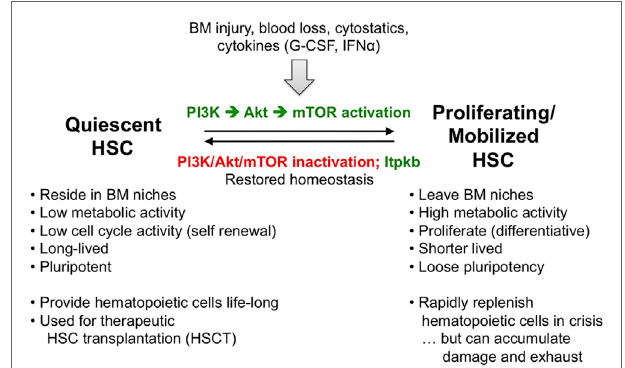
FigURe 6 | Hematopoietic stem cell (HSC) homeostasis is an exquisitely phosphoinositide 3-kinase (PI3K)-dependent process controlled by Itpkb. To ensure live-long hematopoiesis, HSC reside in BM niches and have low metabolic and cell cycle activity. As a consequence, HSC are long-lived and pluripotent. Stresses including BM injury, blood loss, exposure to cytostatic drugs or cytokines such as G-CSF or type 1 interferons activate and mobilize HSC to leave the BM niches, become metabolically active and proliferate. Some HSC daughter cells then differentiate into hematopoietic progenitors ( Figure 2 ). As a consequence, activated HSC are short-lived and loose their pluripotency. This serves to rapidly replenish hematopoietic cells in a crisis or after HSC transplantation, but persistent HSC activation can lead to HSC damage and exhaustion, ultimately causing BM failure, anemia, immunodeficiencies, or blood cancer (85–87). To prevent this, resolution of HSC-activating stresses normally reverts them into quiescence once the activating stimuli subside. A key mediator of HSC activation that needs to be inactivated for re-entry into quiescence is PI3K signaling via Akt and downstream mammalian or mechanistic target of rapamycin (mTOR). In addition, we have identified Itpkb as a promoter of HSC quiescence and homeostasis that acts at least in part by inactivating Akt in HSC (26,